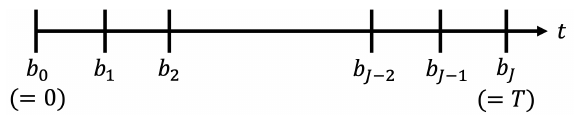
Figure 7. Initial arrival time b j .